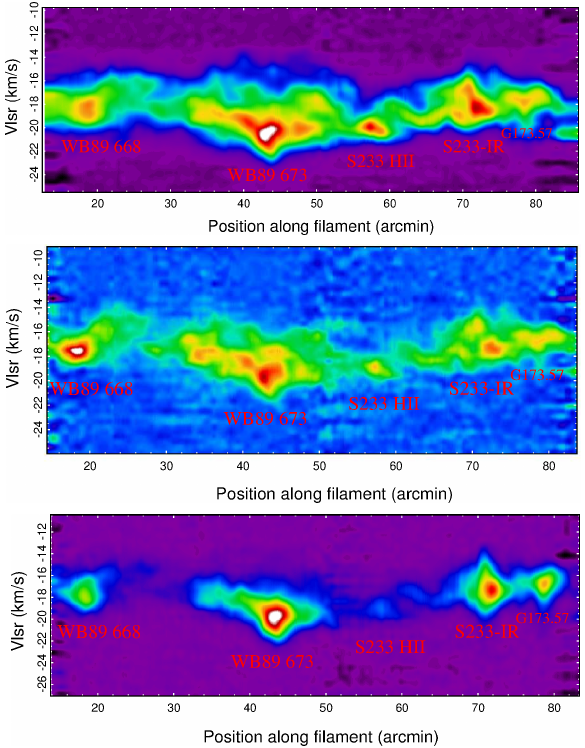
Figure 4. Position-velocity diagrams for 13 CO(1–0) (top), C 18 O(1–0) (middle) and CS(2–1) lines (bottom). Intensity in images increases linearly, with a maximum of 10K in 13 CO(1–0), 1.5K in C 18 O(1–0) and 3.3K in